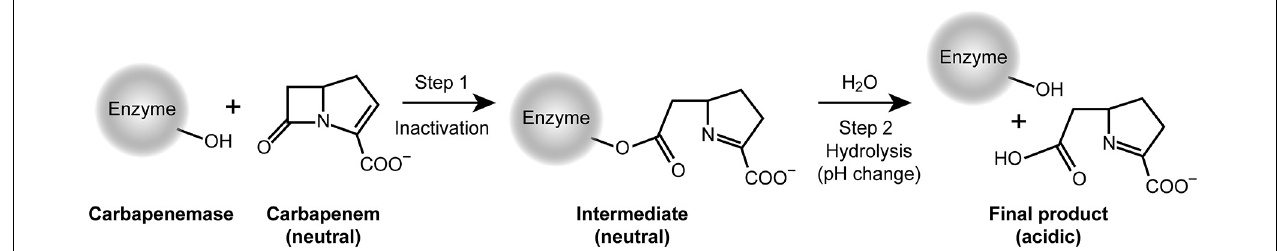
FIGURE 5 | Mechanism relevant for the inactivation of carbapenem antibiotics and detection of carbapenemases.